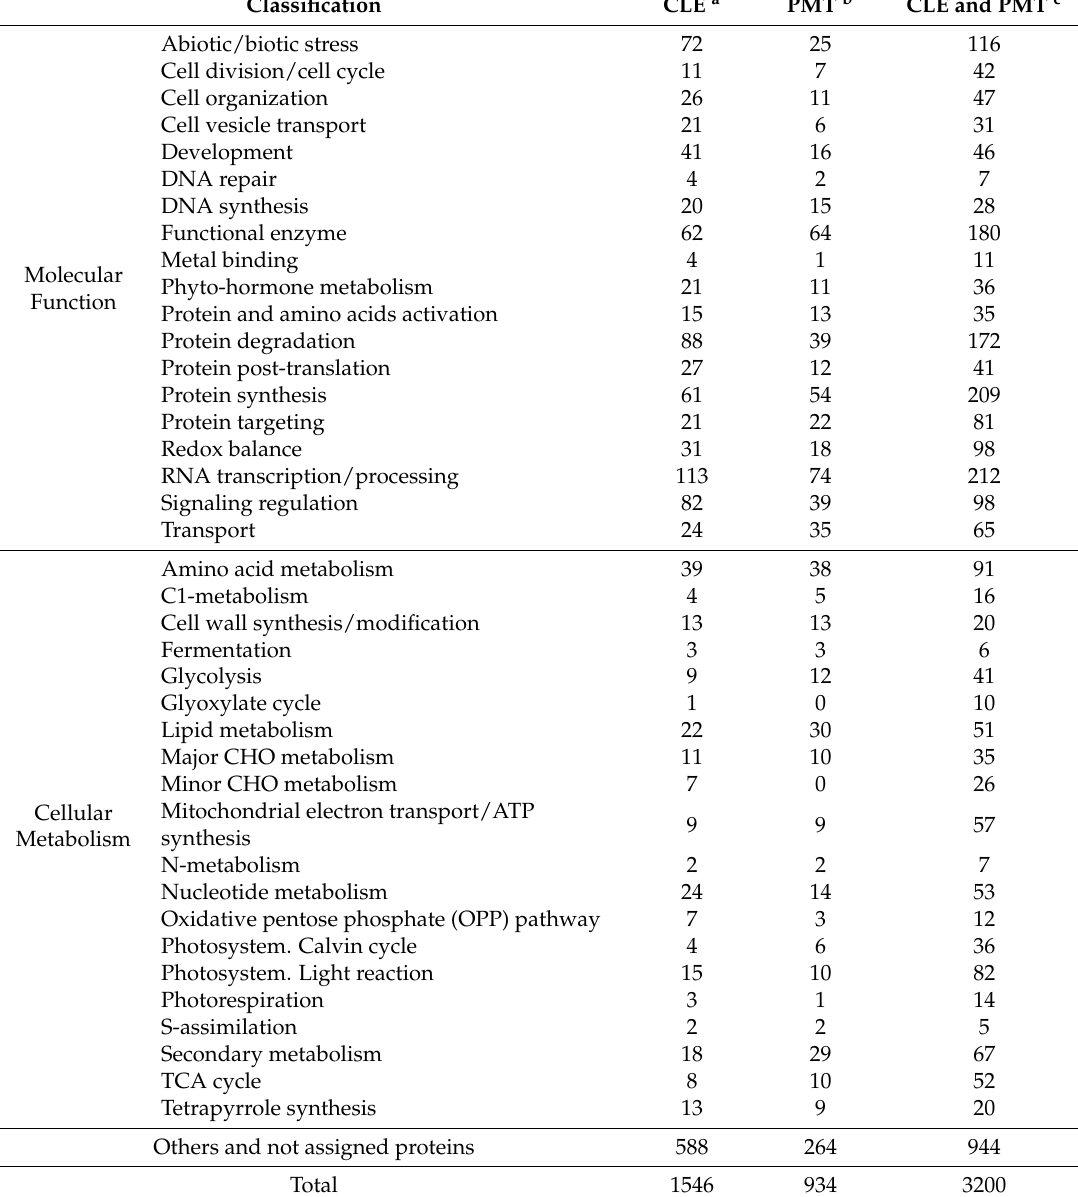
Table 3. The number of proteins identified in the crude leaf protein extracts and ProteoMiner-treated